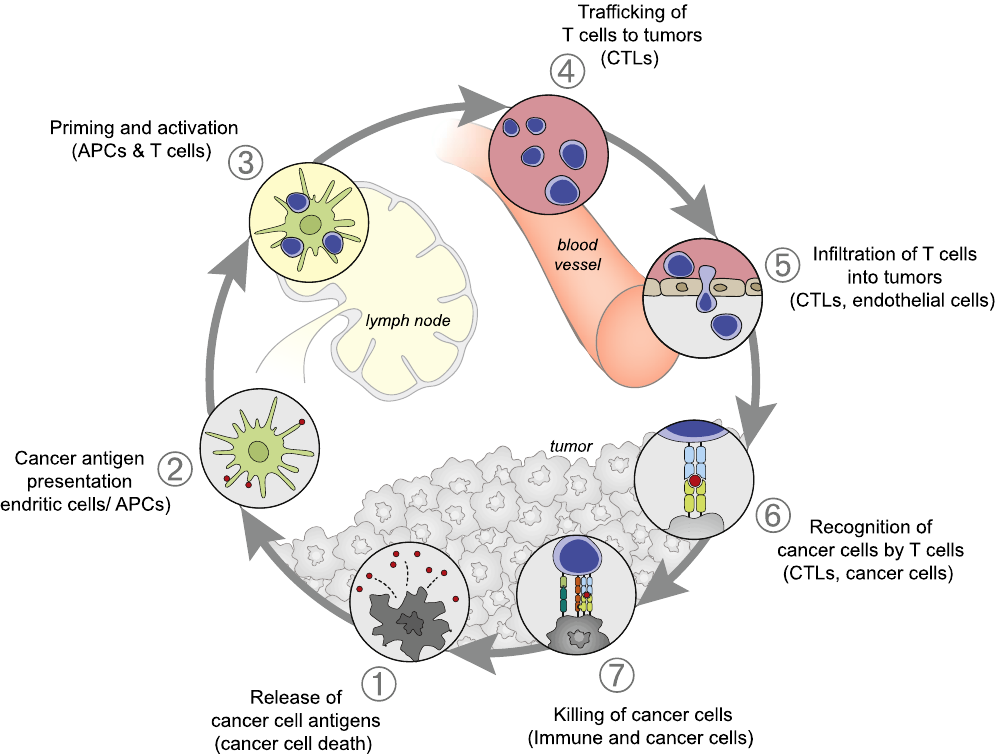
Figure 1. Cancer-immunity cycle: (1) Release of cancer antigens from tumor cells; (2) Presentation of cancer antigens on the major histocompatibility complex class (MHC) by antigen-presenting cells; (3) recognition of cancer antigens on the MHC by the T cell receptor, resulting in T cell activation; (4) Trafficking of activated T cells; (5) Infiltration into the tumor; (6) Recognition of cancer antigens on the MHC within the tumor; (7) Attack on tumor cells, resulting in tumor cell injury/death. This figure was adopted from Chen DS et al. [8].